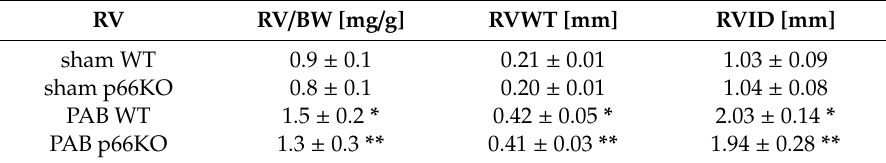
Table 3. Right ventricular weight and ventricular geometry in mice three weeks after pulmonary artery banding (PAB) or sham surgery. Data show the right ventricular weight normalized to body weight (RV / BW in mg / g), the right ventricular wall thickness (RVWT in mm) and the right ventricular inner diameter (RVID in mm). Data are given for wild type (WT) and p66shc knockout (p66KO) mice three weeks after sham surgery ( n = 6 each group) and for WT and p66KO mice three weeks after PAB ( n = 7 and n = 9, respectively). Data are shown as means ± SD. *: p < 0.05 vs. WT sham and **: p < 0.05 vs. p66KO sham as analyzed by two-way ANOVA.